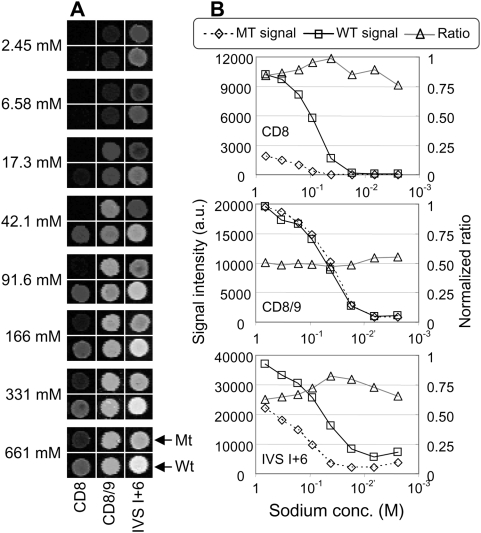
Scanning images of processed arrays and corresponding melting curves.The images show a subset of hybridized probes washed at different sodium concentrations (A). The target material originated from a person heterozygous for the CD8/9 +G mutation. The sodium concentrations in the respective zones are denoted to the left, and the identities of the probes are indicated below the images. Wild-type probes (Wt) for the different mutations and the corresponding mutant probes (Mt) are shown at the bottom and the top of each panel, respectively. The melting curves corresponding to (A) are presented in (B). The wild-type (square) and the mutant (diamond) signal, along with the normalized ratio between those two signals (triangles; see Materials and Methods), are shown for three different mutation sites (CD8 −AA, CD8/9 +G, and IVS I+6 T>C). The graphs are based on the quantified signal intensity (in arbitrary units, a.u.) of the scanning images obtained at the corresponding sodium concentration. For easier comparison with temperature-based dissociation curves obtained previously [5], the X-axis are inverted. All calculations are based on four replicates in each stringency zone. Note that the images in (A) have been changed slightly in terms of contrast and brightness for clarity, whereas the graphs are based on raw signals.